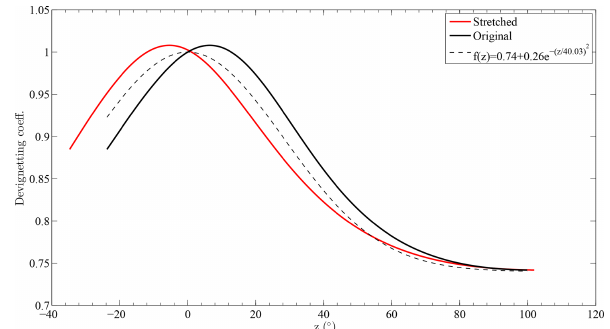
Figure 9. Devignetting coefficient: black line – original data, red line – mirrored curve, dashed line –